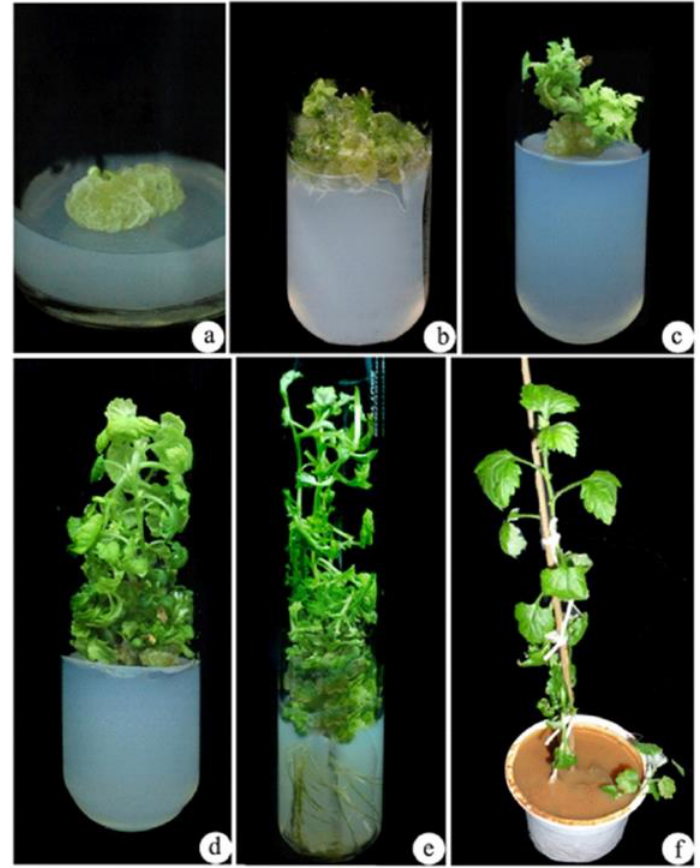
Figure 3. Influence of ethyl methane sulphonate (EMS) 0.5% on the growth of mutants from callus of A. vulgaris on NaCl stressed media. ( a ) Regenerated callus, ( b , c ) shoot induction from callus, ( d ) multiple shoots induction and elongation from callus, ( e ) multiple shoot induction with roots, ( f ) hardened plant in a cup.